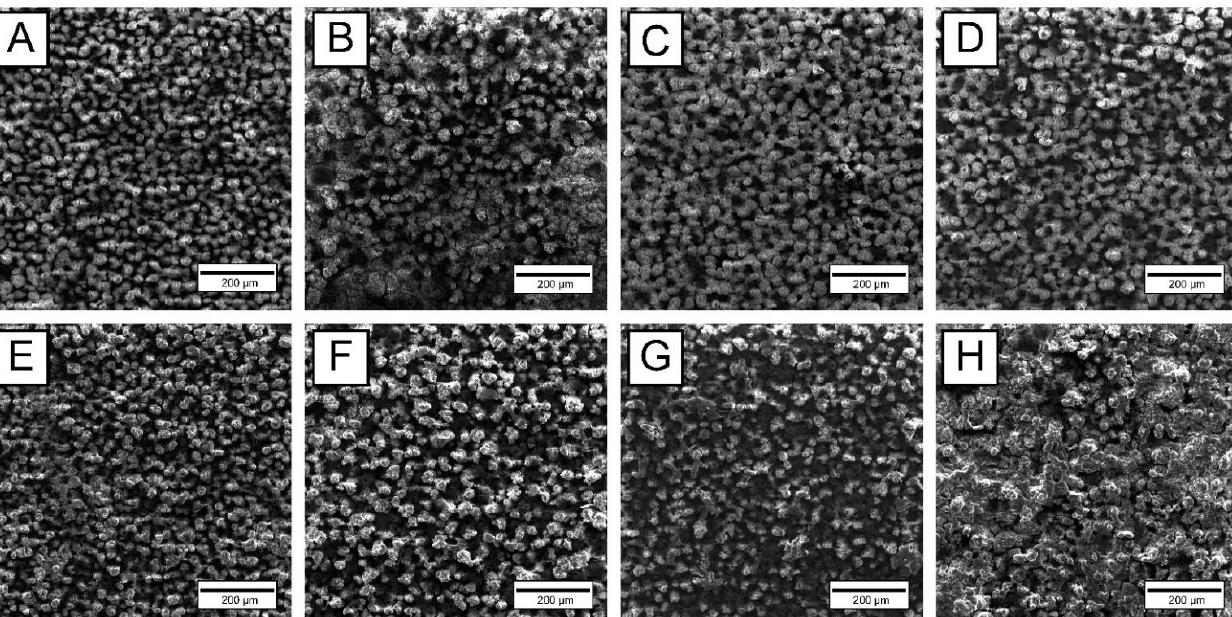
Figure 3. SEM images of surface morphology: MAO coatings Ti-MAO-10-30 ( A , E ), Ti-MAO-10-60 ( B , F ), Ti-MAO-20-30 ( C , G ), and Ti-MAO-20-60 ( D , H ), before ( top row ) and after ( bottom row ) TCT.